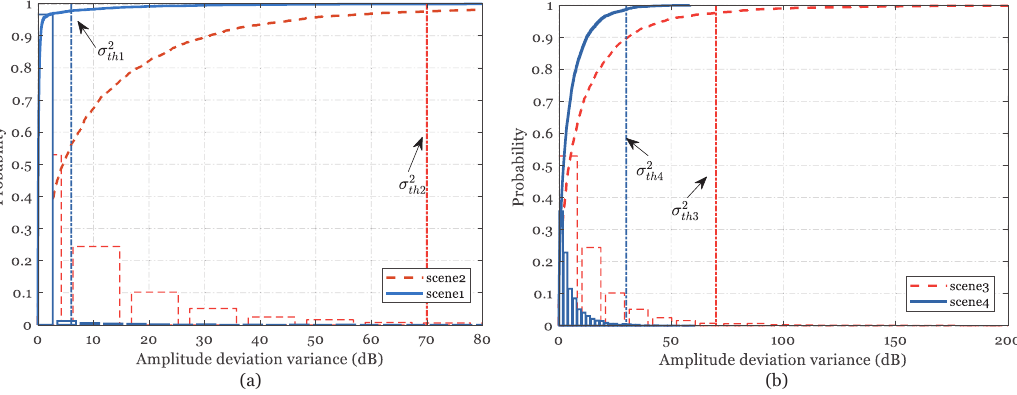
Figure 5. Amplitude deviation variance in different scenes. ( a ) Raw CSI amplitude distribution in single line of sight (LOS) conditions (scene1 & scene2). ( b ) Raw CSI amplitude distribution in complex conditions (scene3 &